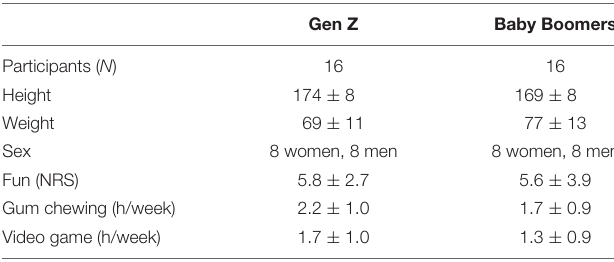
TABLE 1 | Demographic distribution and Numerical Rating Scale (NRS) scores of participants in both the groups. Gen Z Baby